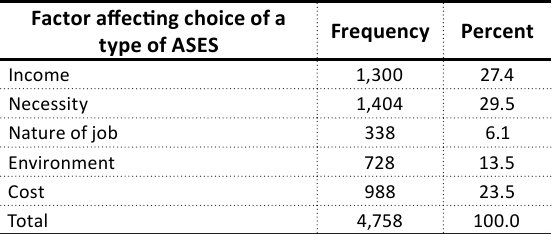
Table 18. Factor affecting choice of ASES